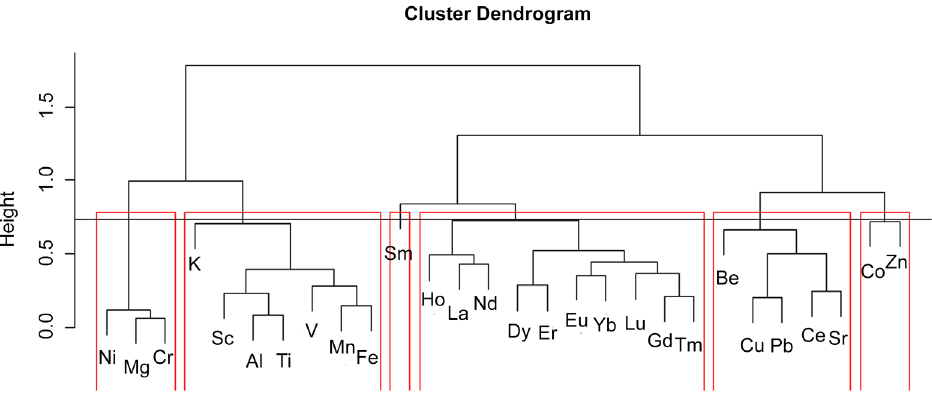
Figure 8. Cluster analysis of major and trace elements in the sediment core BC-10. Red lines indicate different groups obtained by hierarchical clustering.